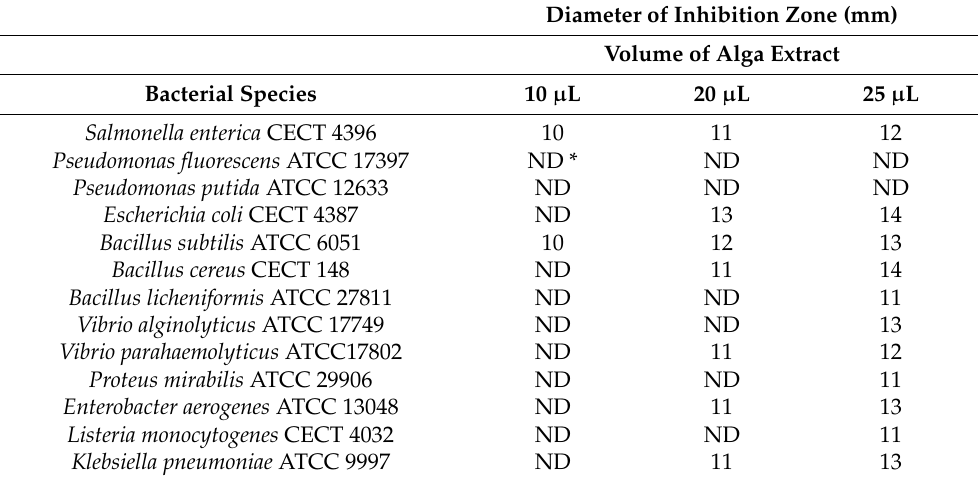
Table 2. Antimicrobial activity of Gelidium flour extract on pathogenic and spoilage bacteria.